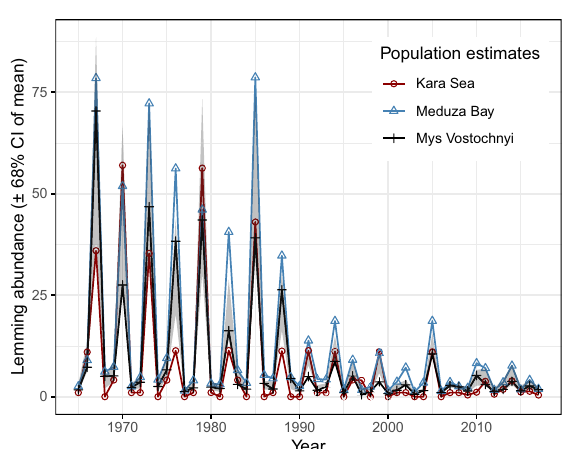
Figure 2. Dynamics of three lemming populations in the Western Taimyr Peninsula (population size estimates). The confidence interval (CI) is related to annual mean values based on the three lemming monitoring programs: Kara Sea, Meduza Bay, and Mys